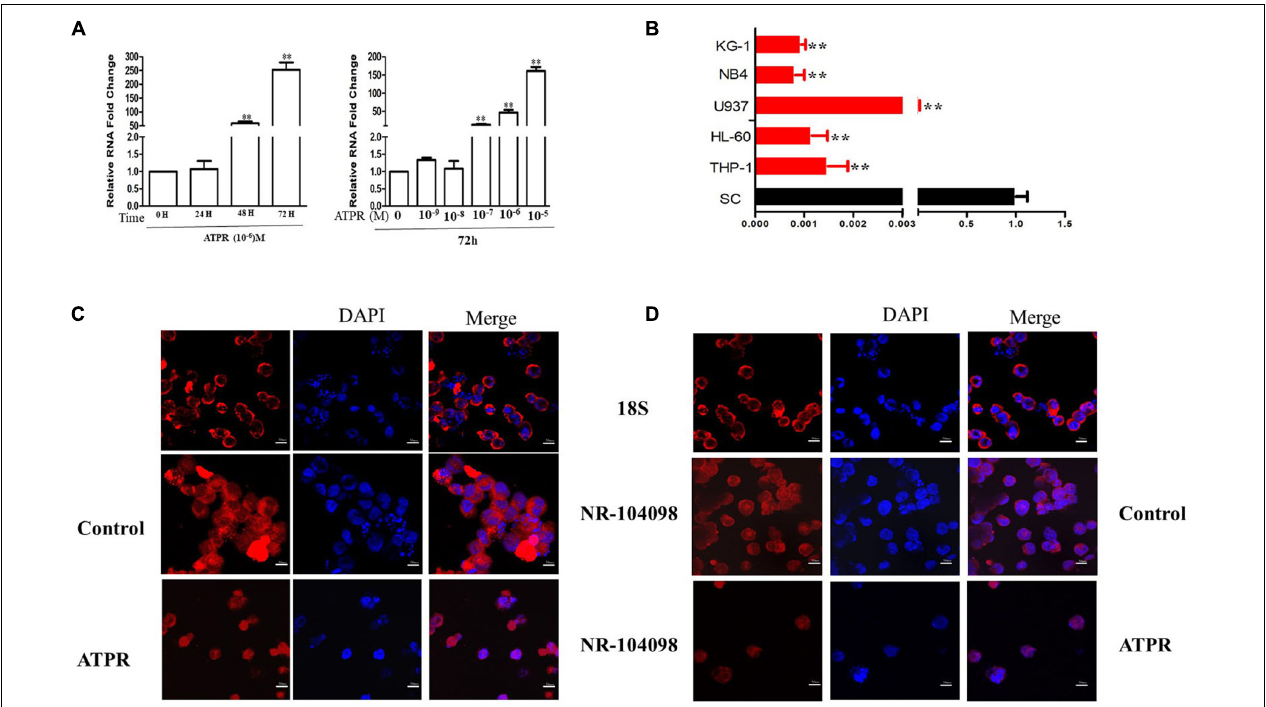
FIGURE 4 | ATPR Induced the Expression of lncRNA NR-104098. (A) NB4 cells were treated with ATPR (10 − 6 M) at different time points (0, 24, 48, and 72 h). NB4 cells were treated with an ATPR concentration gradient (0–10 − 5 M) for 72 h. Then, the mRNA expression of lncRNA NR-104098 were assessed by RT-PCR. (B) RT-PCR analysis of lncRNA NR-104098 expression in AML cell lines and SC cells. (C,D) lncRNA NR-104098 distribution detected by FISH. Values were presented as mean ± SD of three independent experiments. * p < 0.05, ** p < 0.01 versus SC cells